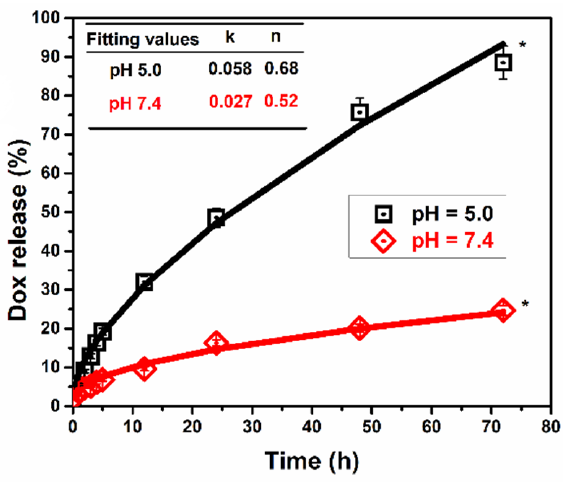
Figure 4. In vitro Dox release kinetics of PA-AgNPs at different pHs. (Data characterize the mean ± SD, n = 3, * p < 0.05, one-way ANOVA.) The solid curves are fitted to experiment data using Equation (1).